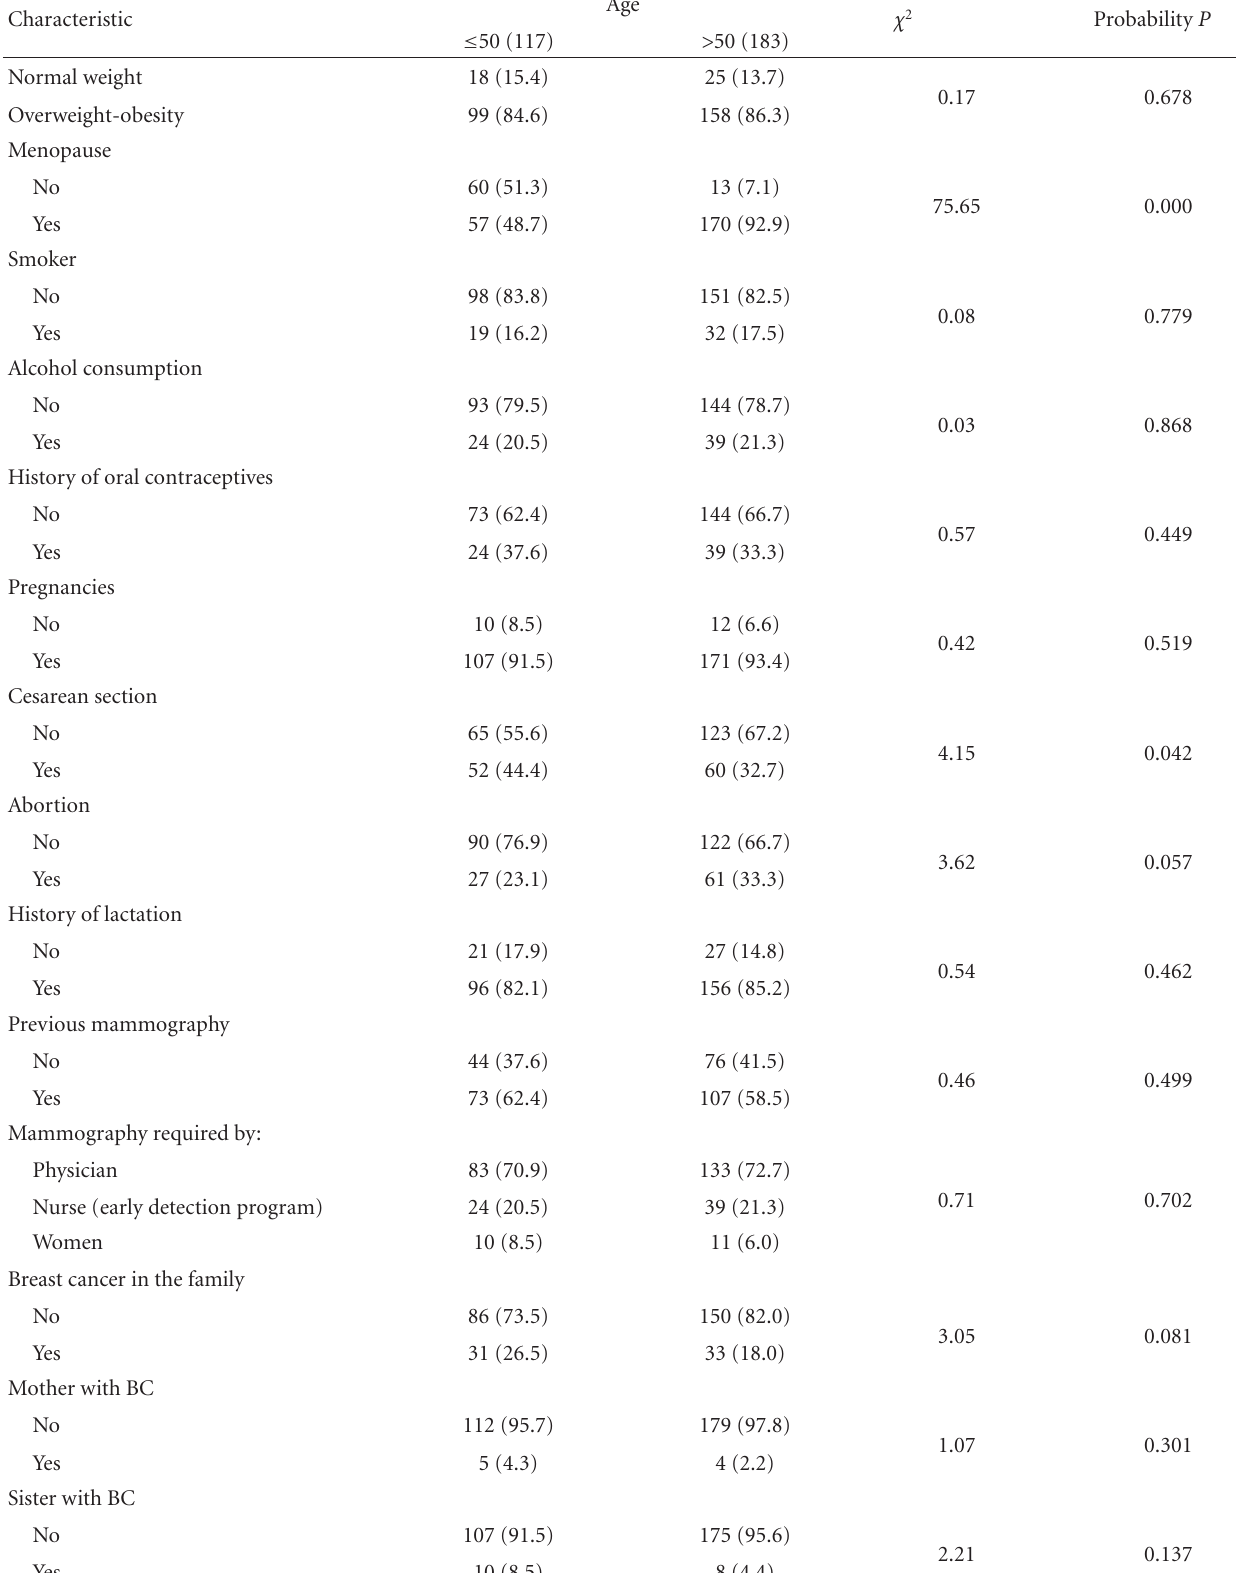
Table 2: Distribution of characteristics according to